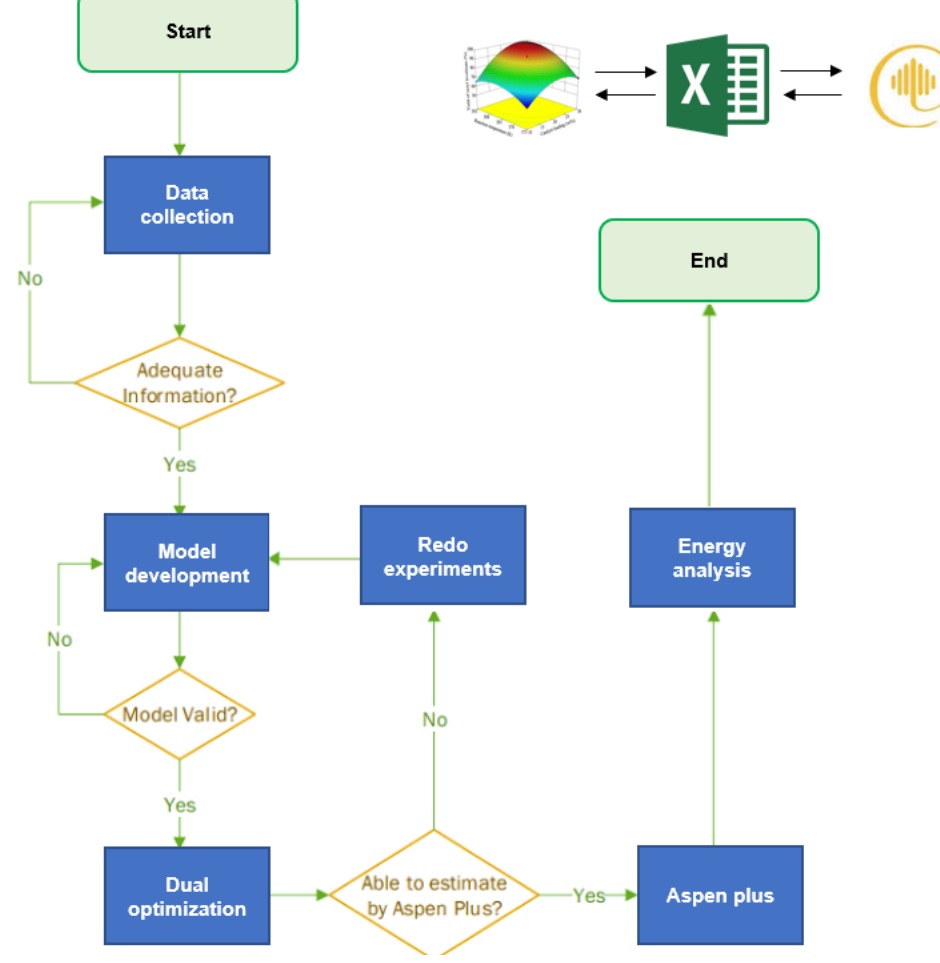
Figure 5. Research methodology flowchart of this study.